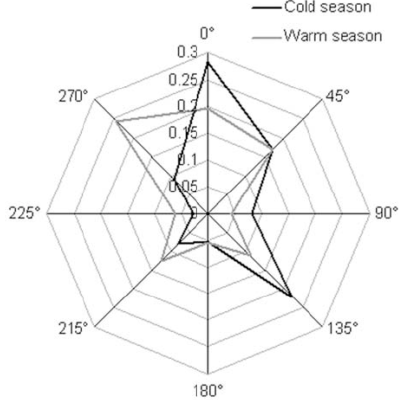
Figure 28. Wind directions in the warm season and the cold season [12].